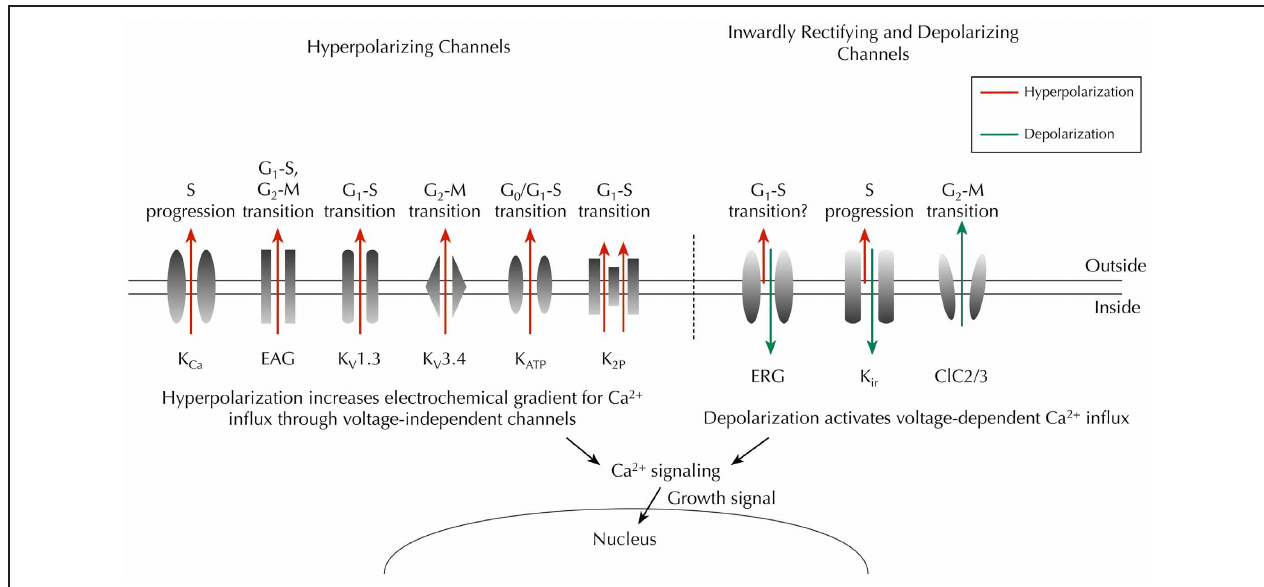
domain-dependent Ca 2 + signaling is then proposed to activate pathways that promote cell cycle progression and proliferation. Abbreviations: K Ca , Ca 2 + -activated K + channel; EAG, ether à go-go channel; K v , voltage-gated K + channel; K ATP , ATP-sensitive K + channel; K 2 P , two-pore domain K + channel; ERG, EAG-related gene K + channel; K ir , classic inward-rectifier K + channel; ClC2/3, chloride 2/3